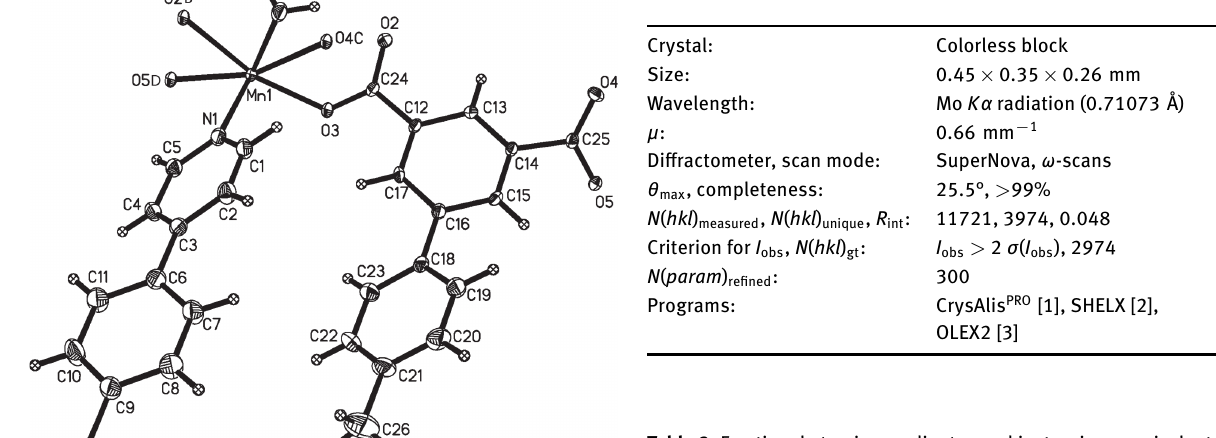
Table 2: Fractional atomic coordinates and isotropic or equivalent isotropic displacement parameters (Å 2